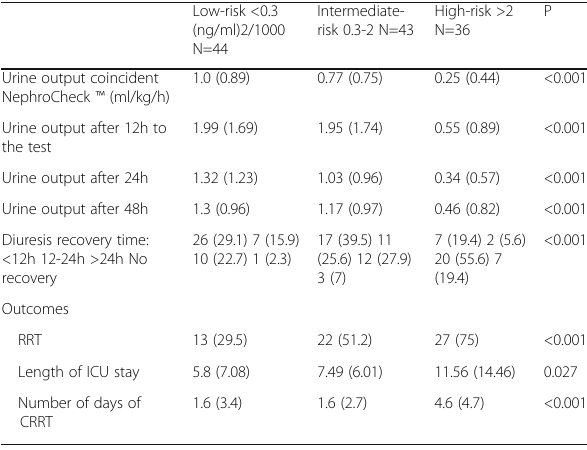
Table 1 (abstract 0406). Comparison of the variables analyzed by the three groups. Continuous variables are given as mean (standard deviation); categorical, as number